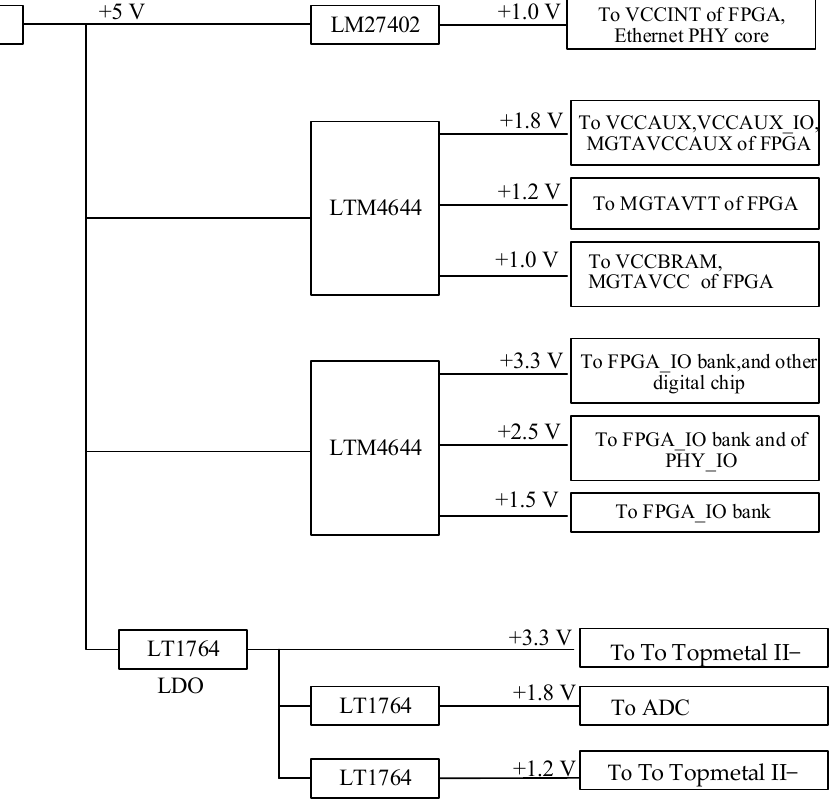
Figure 9. The power distribution of the RCM.